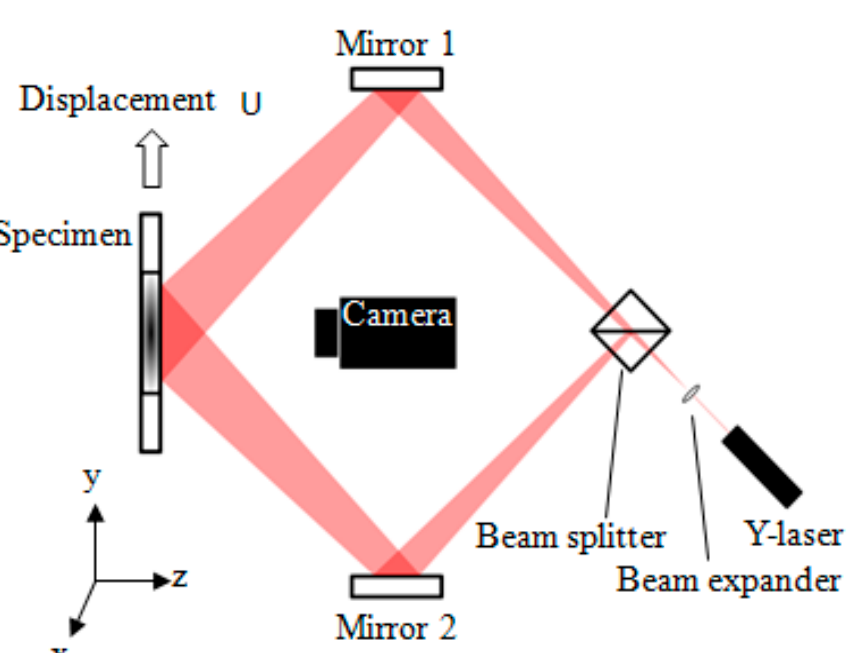
Figure A2. Optical system of